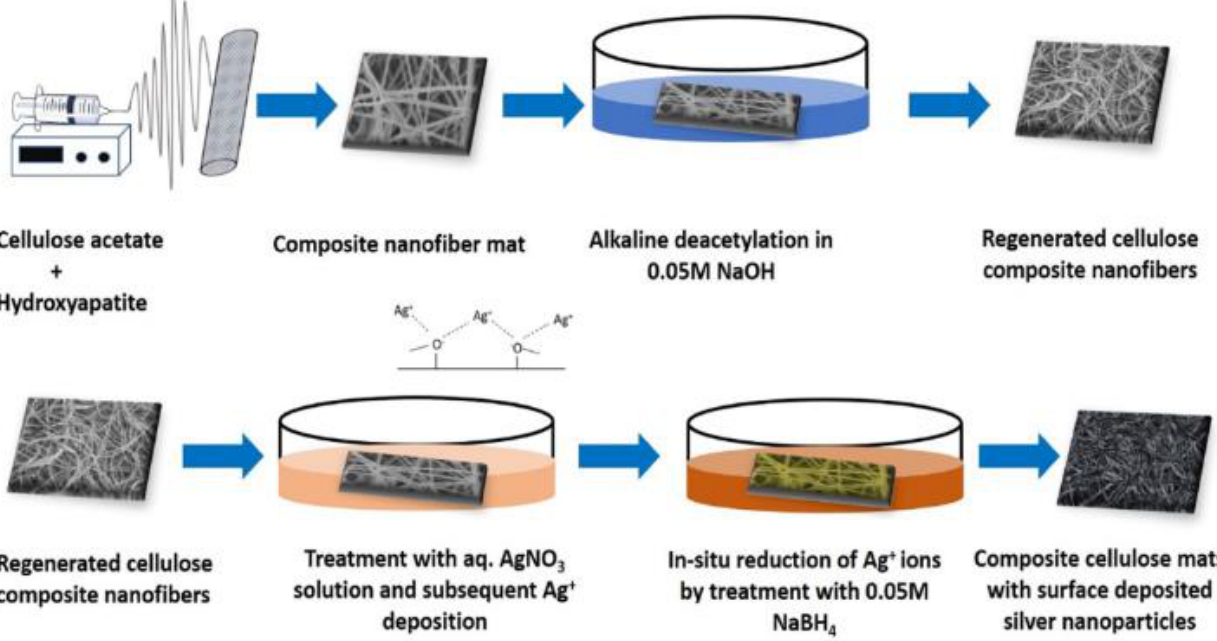
Figure 7. Schematic representation of the fabrication of regenerated cellulose nanofiber mats contain- ing HAp and Ag NPs. Sequential steps are shown to describe the various process involved in the fabrication process (reproduced with permission after [235] ).